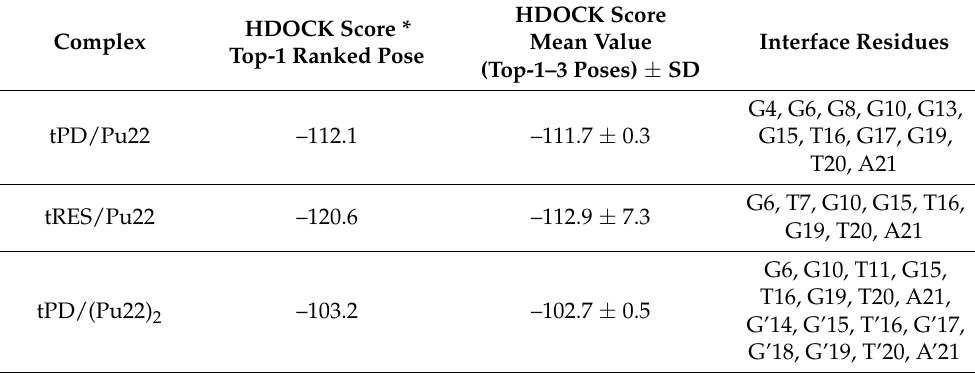
Table 2. HDOCK docking scores (for the top-ranked pose and mean value from the top-1–3 poses). The interface nucleotide residues within 5.0 Å from the ligand in the top-1–3 complexes are reported in the last